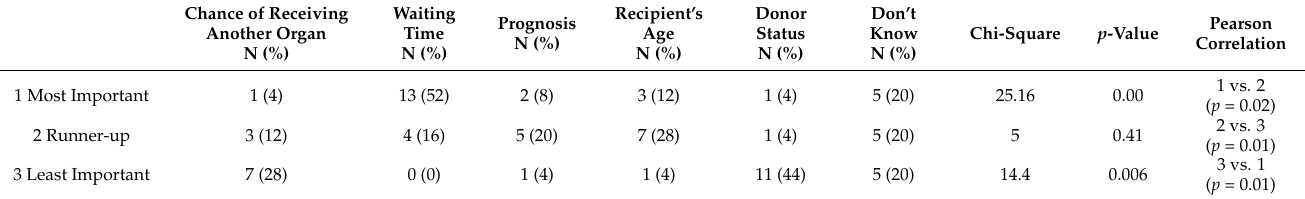
Table 5. Expert’s estimations about the general public